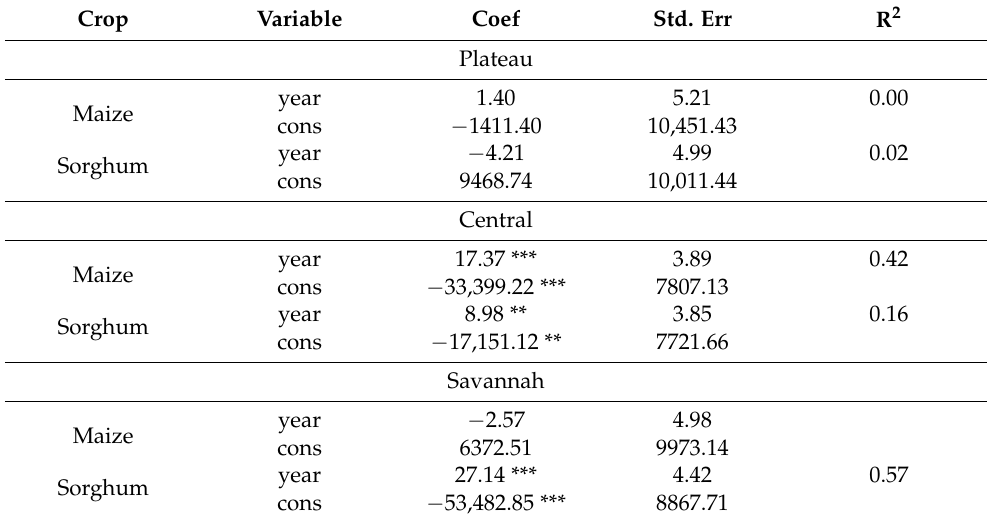
Table 3. Regression results of maize and sorghum yield over time